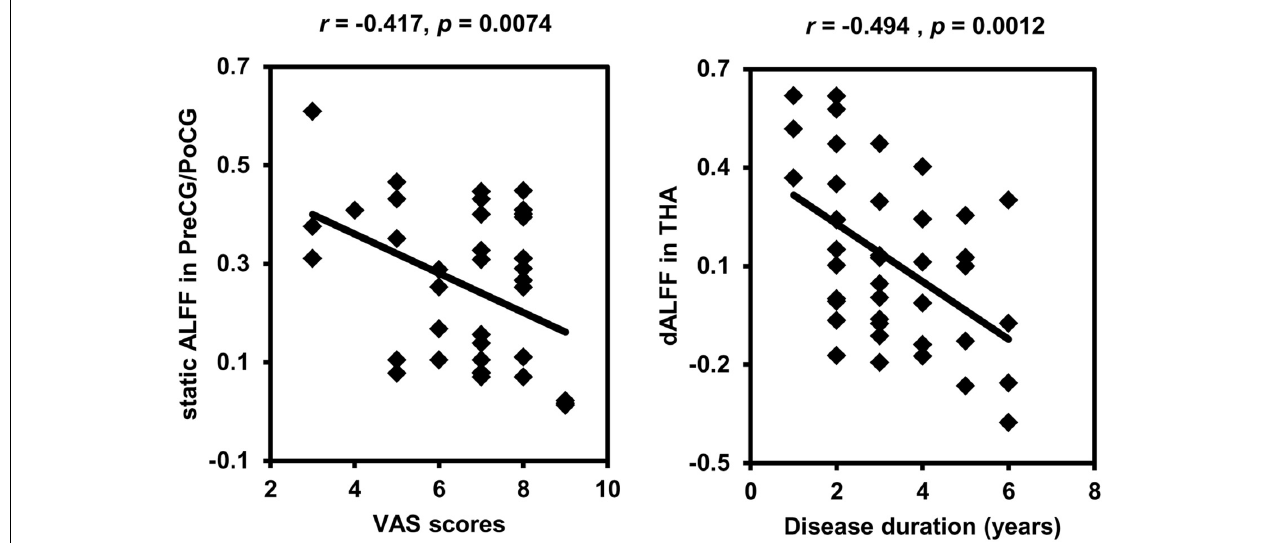
FIGURE 3 | Correlation analyses between static, dynamic ALFF and clinical characteristics. Significant correlations were found between the static ALFF in left precentral/postcentral gyrus and VAS scores and between the dynamic ALFF in left thalamus and disease duration in CDP